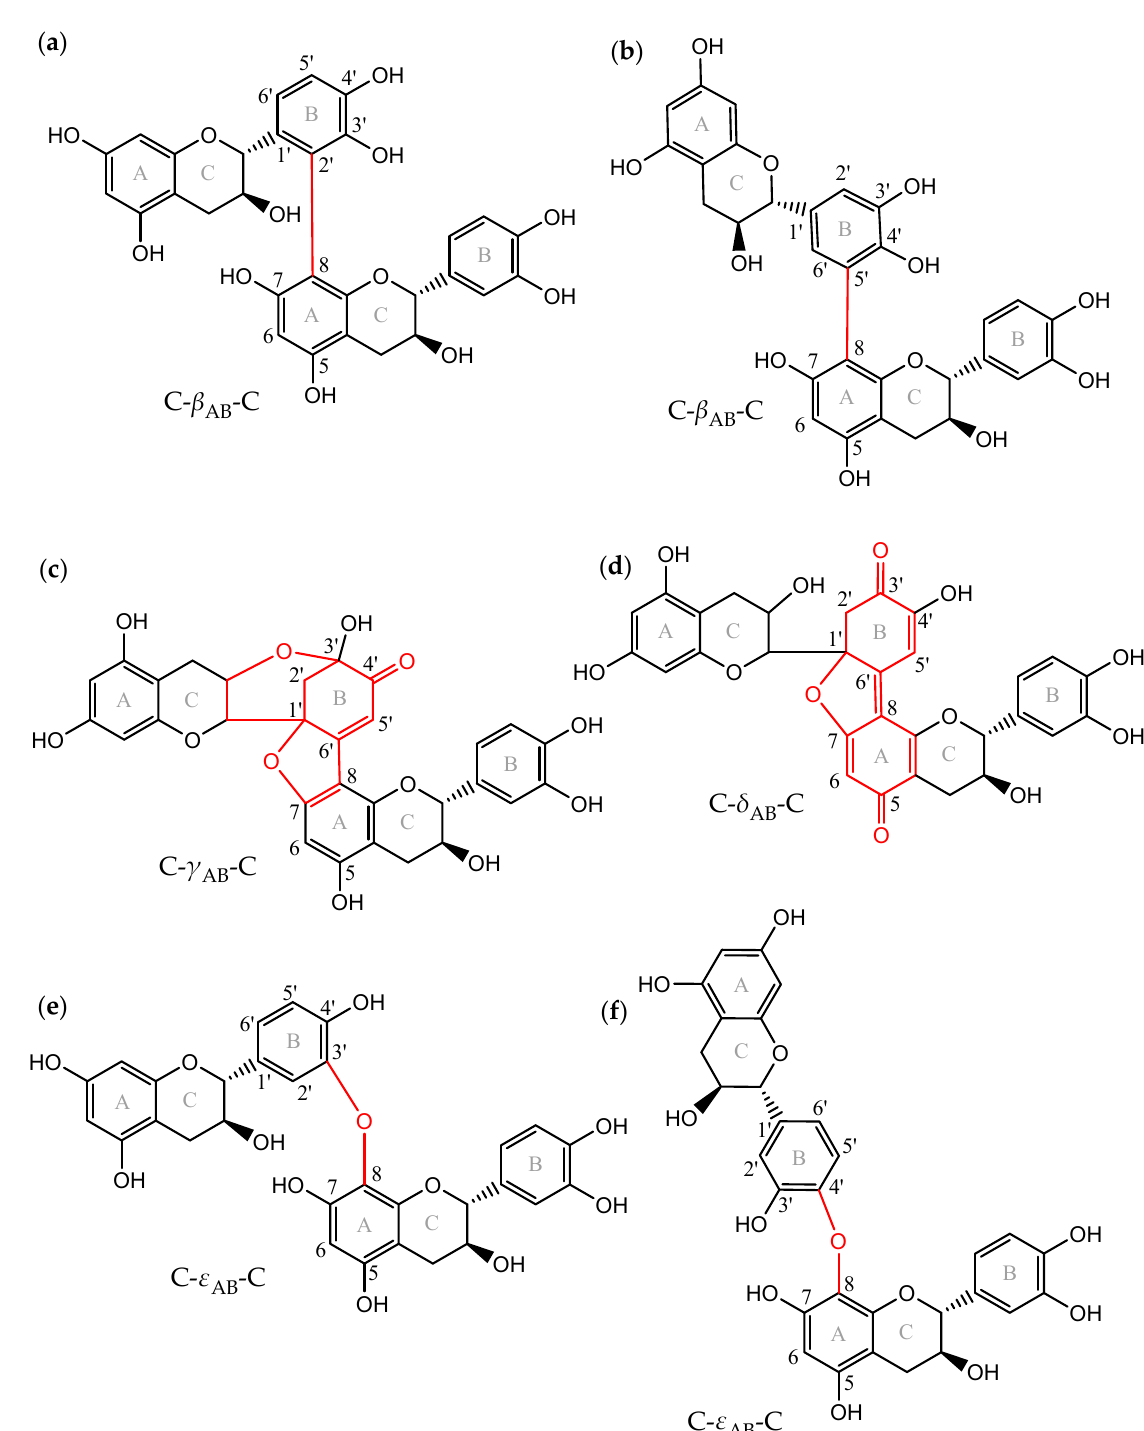
Figure 1. Dehydrodicatechins with different interflavanic configurations (in red): ( a , b ) compounds with β -configuration, ( c ) γ -configuration, ( d ) δ -configuration, and ( e , f ) ε -configuration. Exact mass is 578.1424 u for ( a , b , e , f ) and 576.1268 u for ( c , d ), corresponding to superior oxidation states. Nomenclature is briefly described in the Introduction section and proposed by Verloop and co-workers [14]. ( a – c , e , f ) correspond to N2, N4, N8, N3, and N6 standards, respectively, that were used in the present work. Adapted from Deshaies and co-workers [15] and Verloop and co-workers [14]. Dehydrodicatechins have been analyzed by LC-MS/MS in different matrices such as black tea [14], green tea [4], beer [16], processed cocoa powders [17], and in wines and